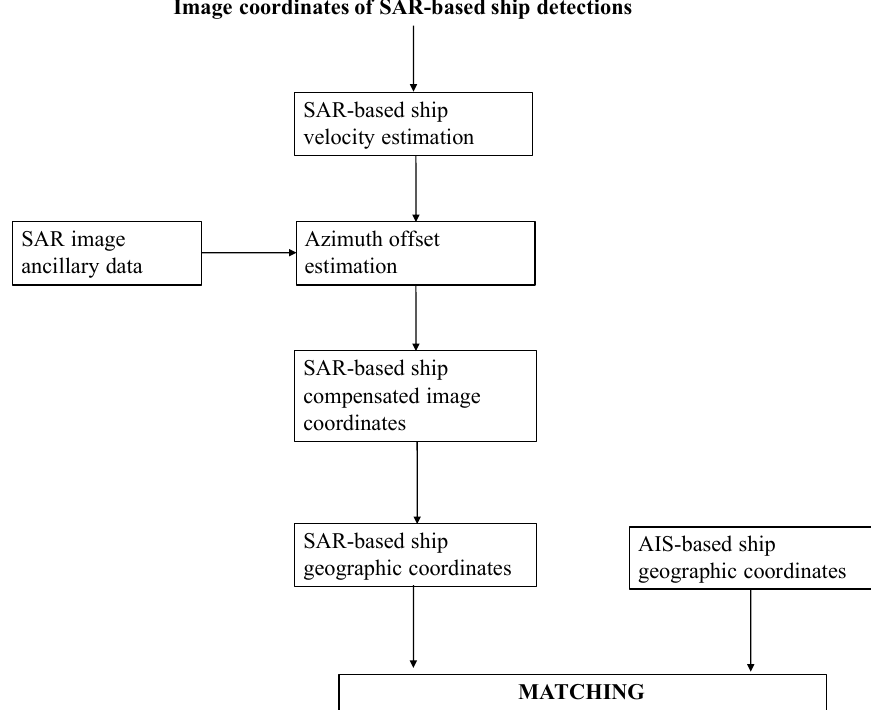
Figure 3. Flow-chart of the proposed AIS-SAR matching approach exploiting SAR-based ship velocity estimation.